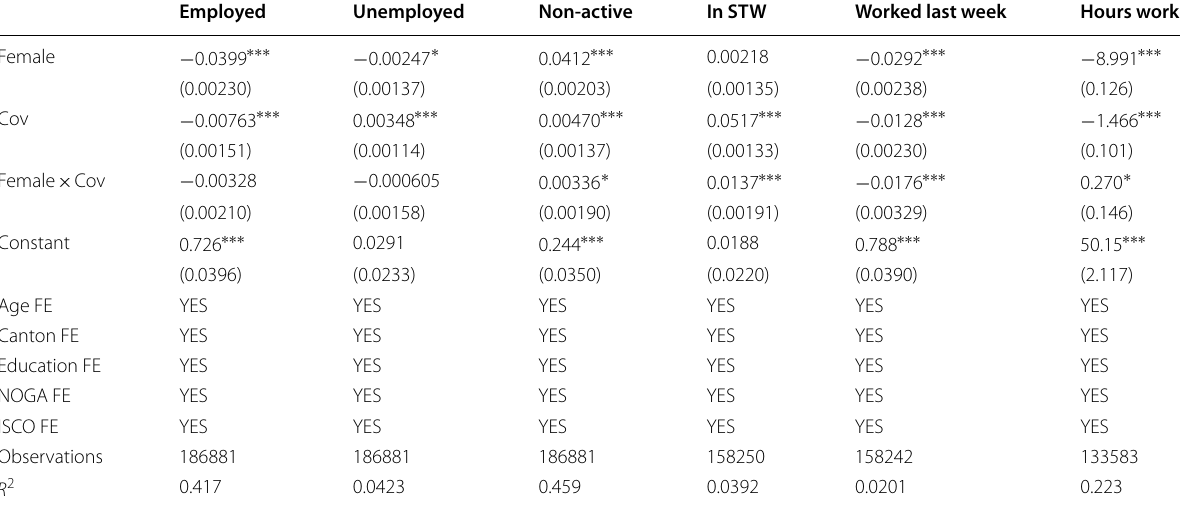
Estimates from regression (1) of labor market status, being in STW, worked last week and hours on a constant, female dummy, COVID-19 dummy, and its interaction with the female dummy. Regressions estimated with linear probability model, including random effects. Robust standard errors in parentheses * p <0.1, ** p <0.05, *** p